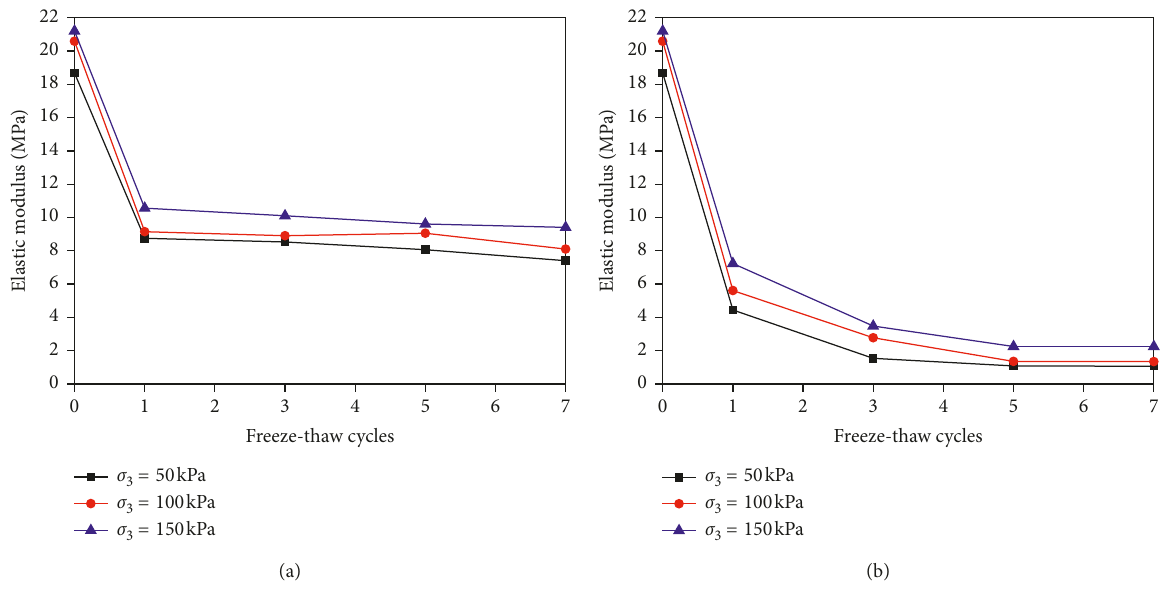
Figure 12: Variation of elastic modulus with the number of freeze-thaw cycles. (a) Closed system. (b) Open